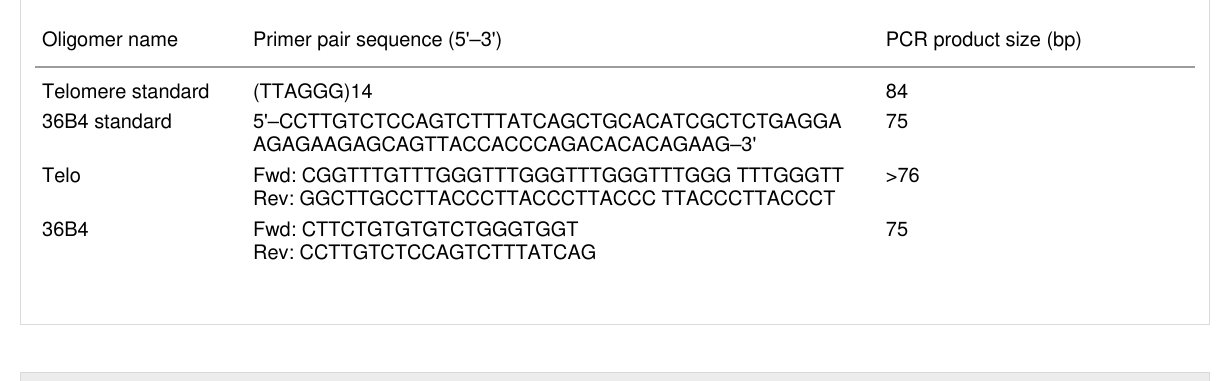
Table 3: Primer sequences used for the real-time PCR